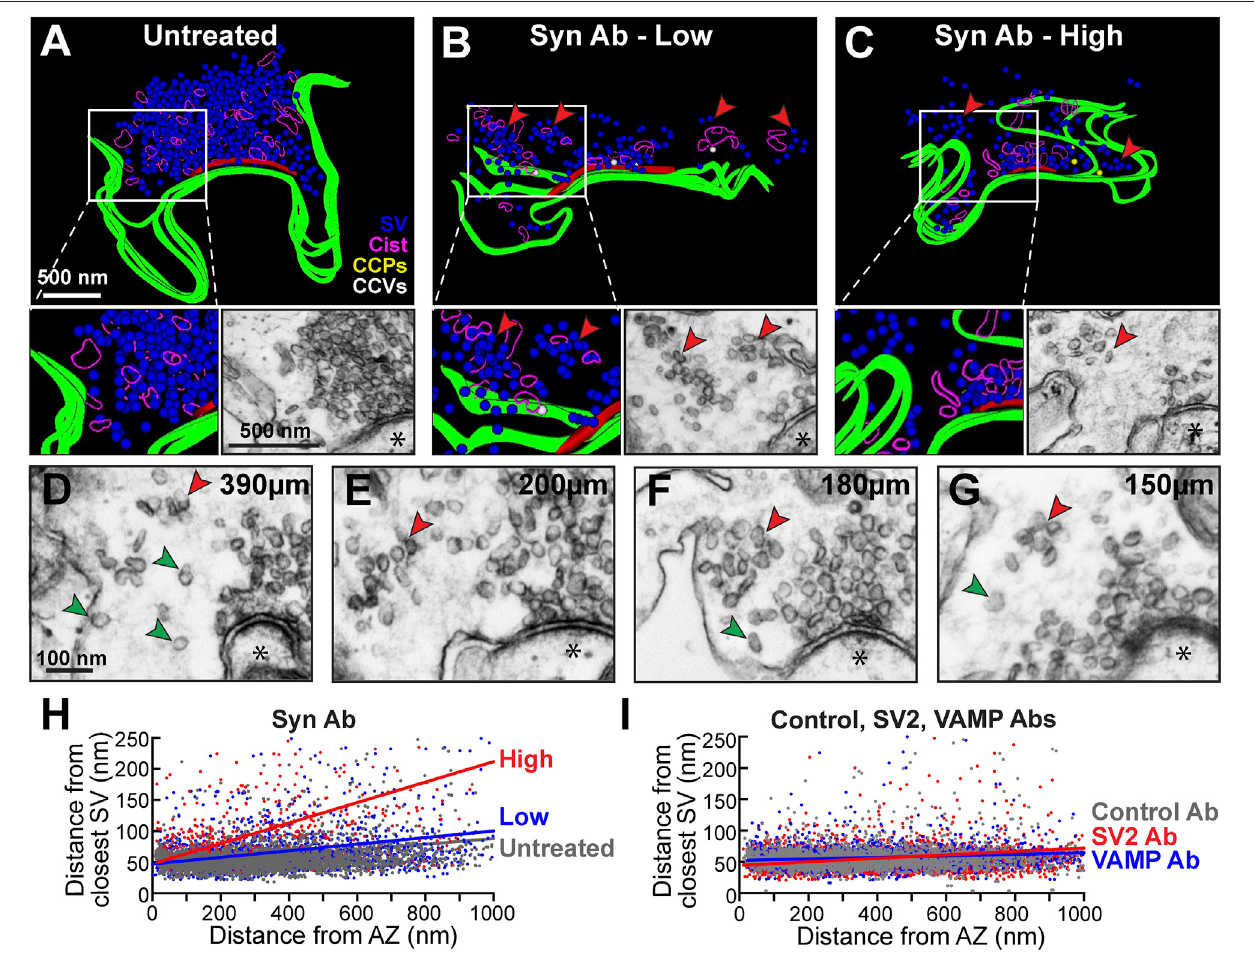
FIGURE 5 | Inhibition of synuclein causes synaptic vesicle de-clustering at resting synapses. (A – C) 3D reconstructions of Untreated synapses and those treated withSynucleinantibody(lowandhighconcentrations).InhibitingsynucleinfunctioncausesSVstode-clusterintosmallerclumps(B-Cinsets,redarrowheads).Scalebar inAappliesto (B – C ). (D – G) ElectronmicrographsshowingadditionalexamplesofSVde-clusteringintoSVsubclusters(redarrowheads),aswellasindividualsingleSVs (green arrowheads). Asterisks indicate postsynaptic densities. Scale bar in D applies to (E – H) . (H – I) Nearest neighbor analysis revealed SV de-clustering after treatmentwiththesynucleinantibody,especiallyathigh concentrations.ThiswasnoobservedwithhighconcentrationsoftheControl, SV2,or VAMPantibodies,where most SVs remained tightly clustered within 50 – 70 nm away from their nearest neighbor. Data points are from n (cid:2) 676 – 3793 SVs, 23 – 31 synapses, 2-3 axons/animals.